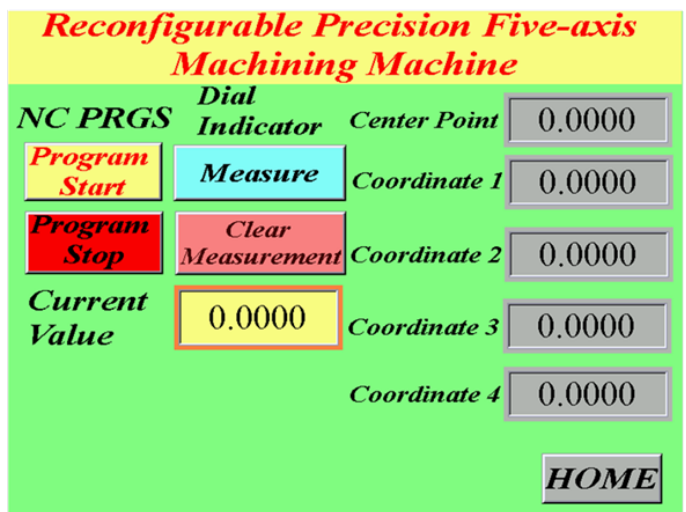
Figure 5. Real-time display of measured values on the human – machine interface.